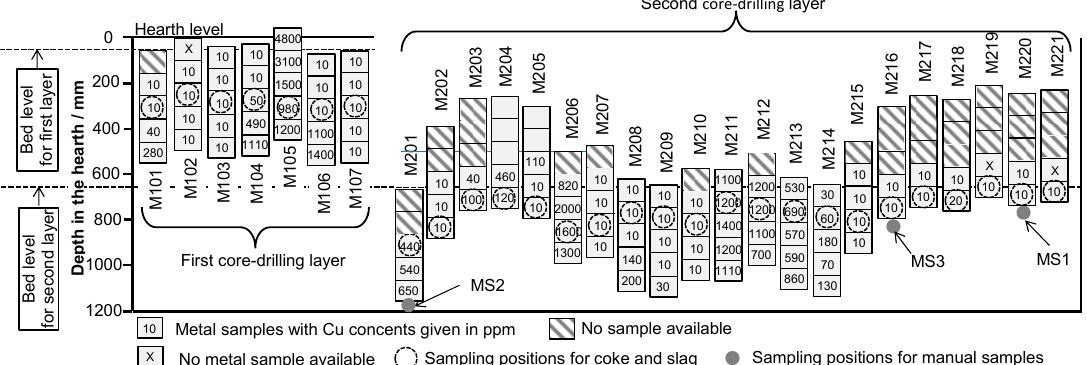
Figure 2. Illustration of the sampling positions (with respect to the depth in the hearth) of the core ‐ drilling samples and manual samples (numbers in the squares indicate Cu contents in the metal samples given in ppm).